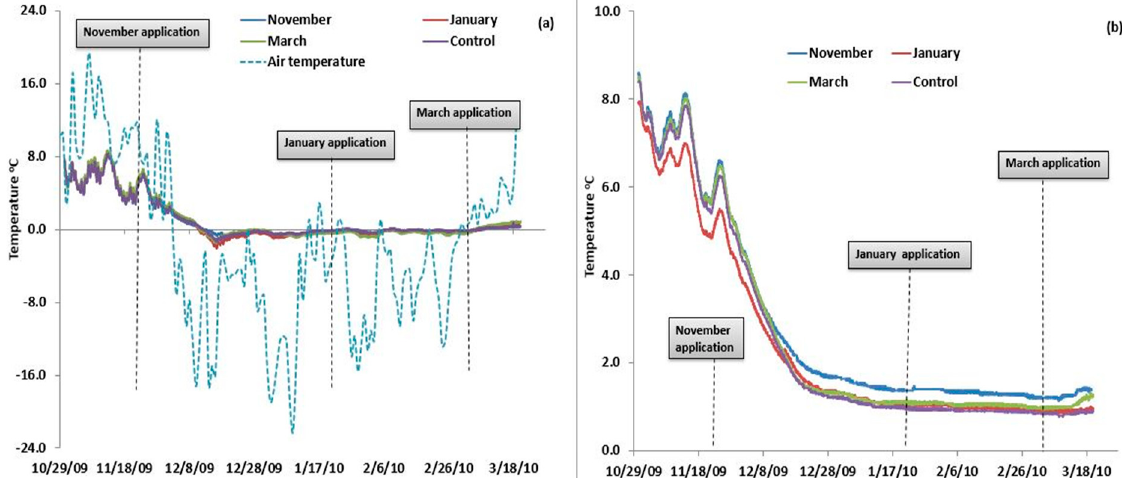
Figure 6. Air temperature and below ground soil temperature at ( a ) 15 cm and ( b ) 51 cm soil depth for manure timing treatments (mean overall manure treatments); Brookings, SD.